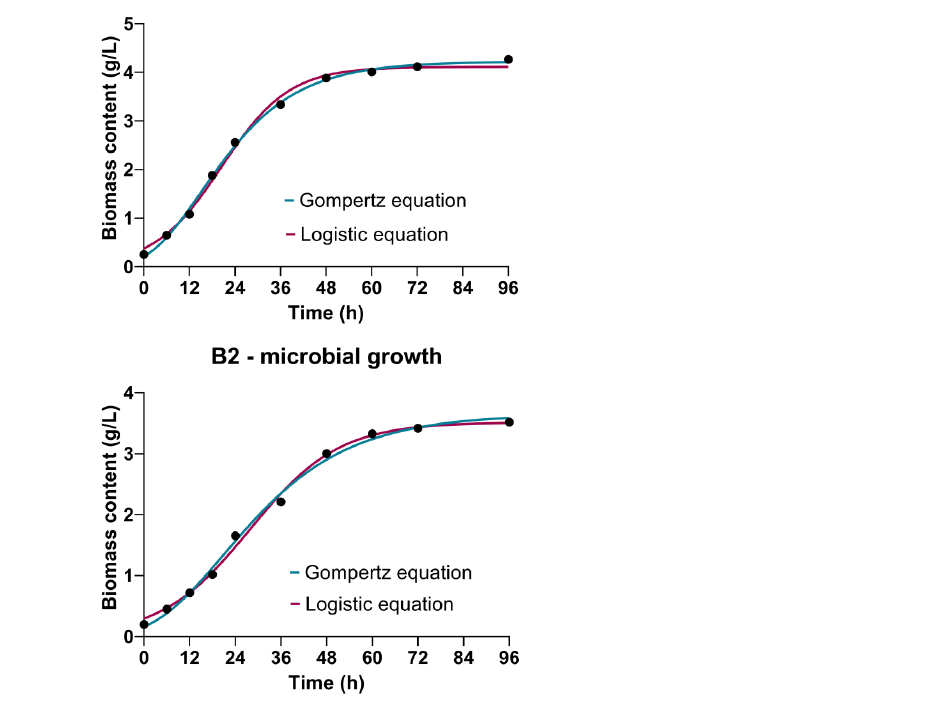
Figure 2. Bioprocess kinetics in terms of Bacillus sp. BioSol021 growth during cultivations in a 16 L bioreactor using the food industry effluents-based media: B1—cheese whey from dairy industry, B2—winery flotation wastewater.